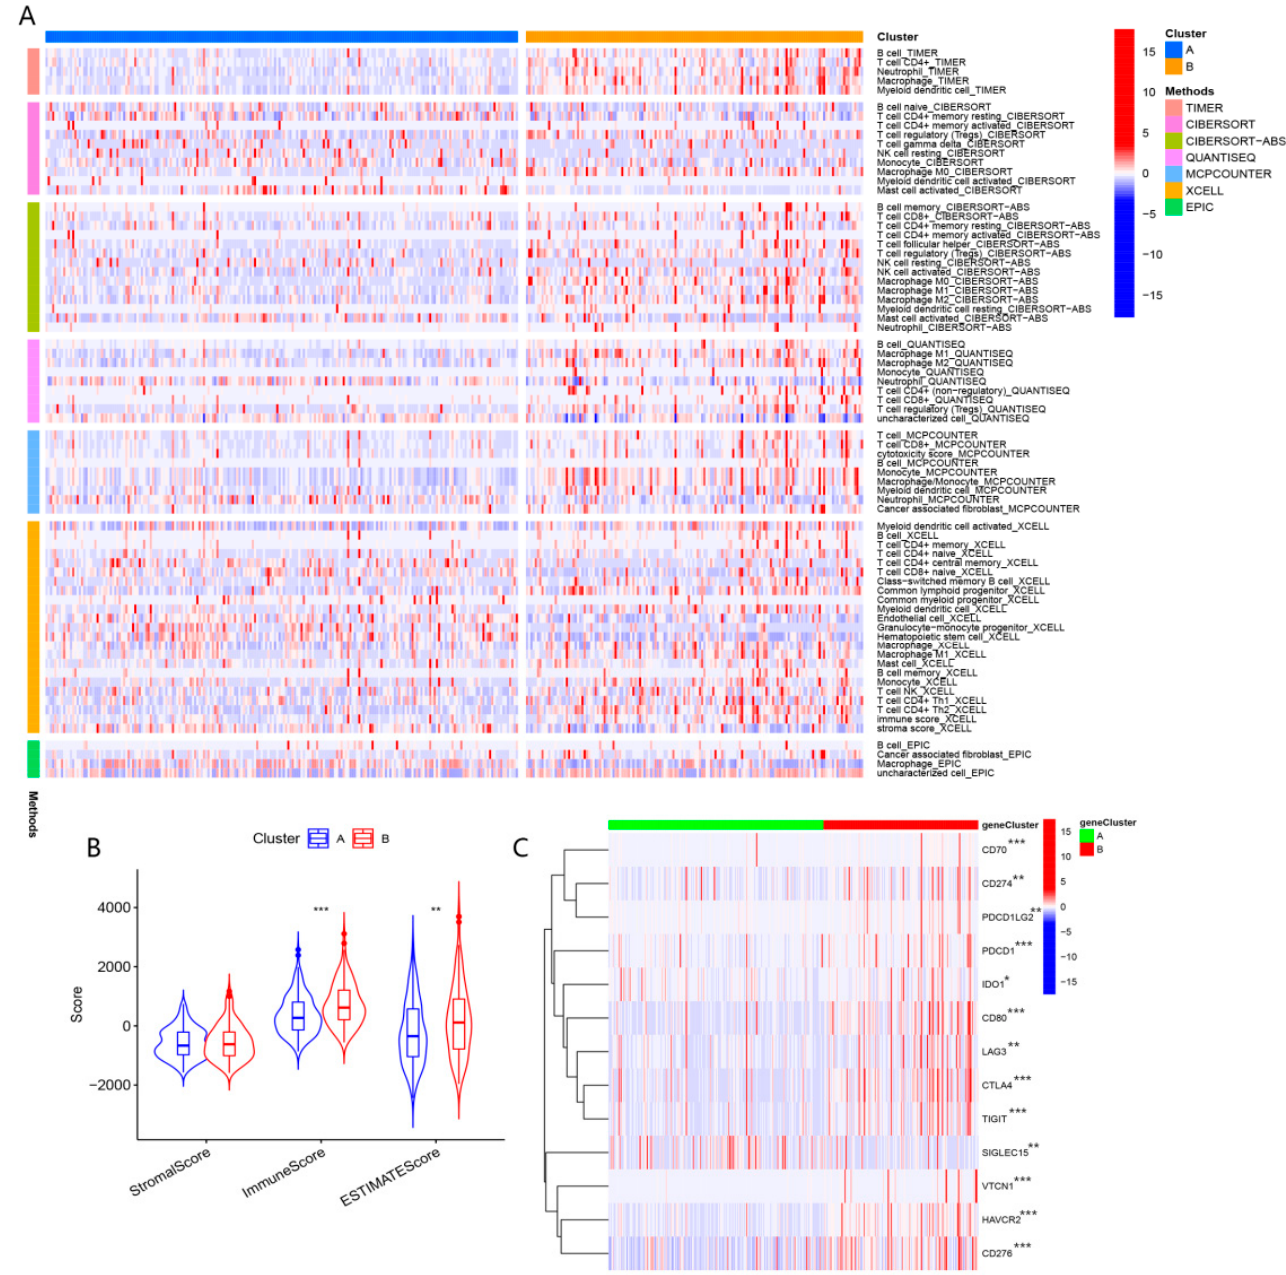
Figure 3. ( A ) Comparison of immune cell infiltration in clusters A and B based on seven algorithm. ( B ) Comparison of TME in clusters A and B. ( C ) Comparison of expression levels of immune check- point in clusters A and B. (“*”, “**”, “***” represent p < 0.05, p < 0.01, p < 0.001,